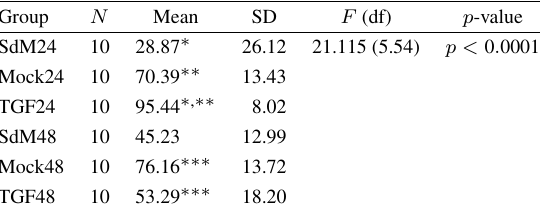
Fig. 7. Increased matrigel invasion at both 24 and 48 h following TGF- β 1 treatment. The number of cells in 10 random high power fields (HPF) images on each filter was counted using × 40 objective on a Leitz Labrolux K (Germany) light microscope. The brackets contain the median cell counts/HPF and n – the number of HPF assessed for each group. Significantly more TGF- β 1 treated cells migrated into the matrigel at both 24 and 48 h compared to SdM ( p < 0 . 01, Mann–Whitney U). (The colors are visible in the online version of the article.)